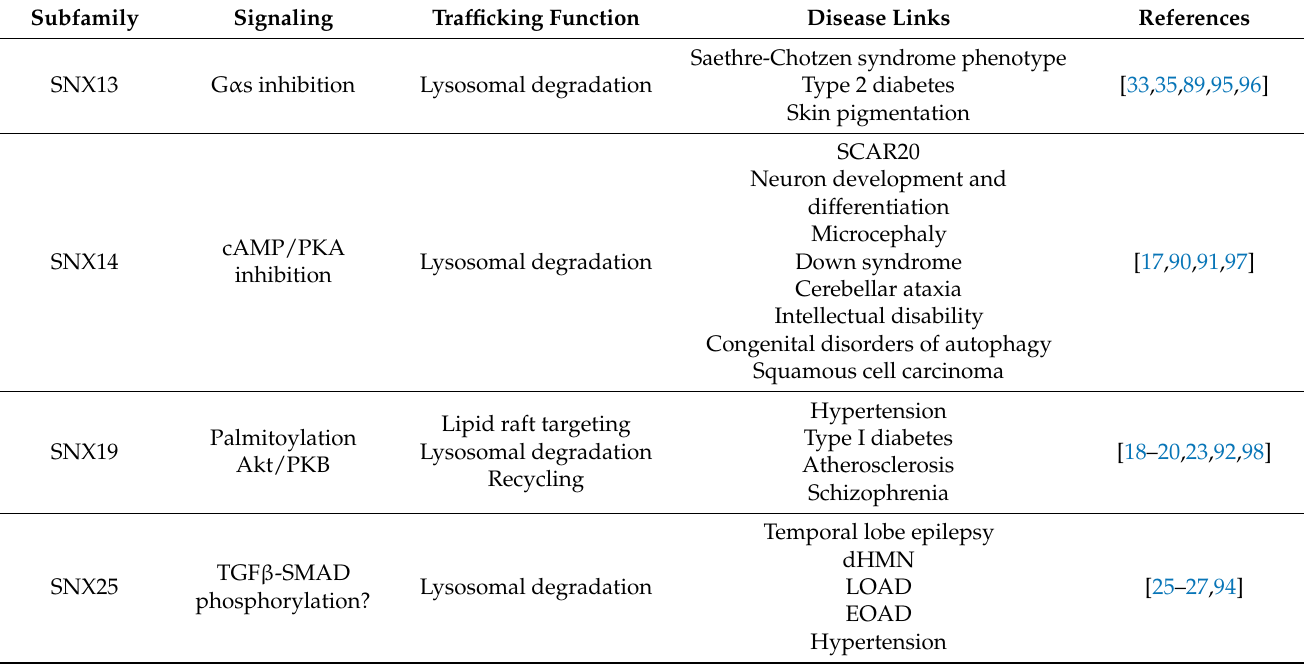
Table 4. SNX-PXA-RGS-PXC subfamily in cellular physiology and implications in diseases.